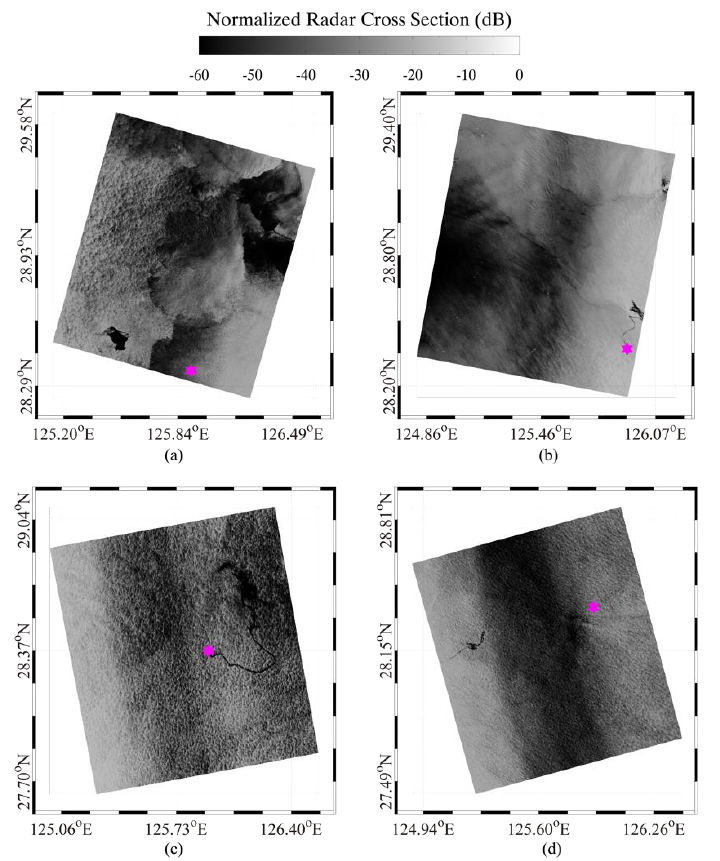
Figure 2. The quick-look maps of four Gaofen-3 (GF-3) synthetic aperture radar (SAR) images of the Sanchi shipwreck in 2018, in which the pinkish marks represent the shipwreck positions. ( a ) The image taken acquired in Fine Stripmap (FS) mode on 14 January at 22:20; ( b ) The image taken acquired in FS mode on 15 January at 21:39; ( c ) The image taken acquired in Stander Stripmap (SS) mode on 17 January at 09:42; and ( d ) The image taken acquired in SS mode on 18 January at 09:01.